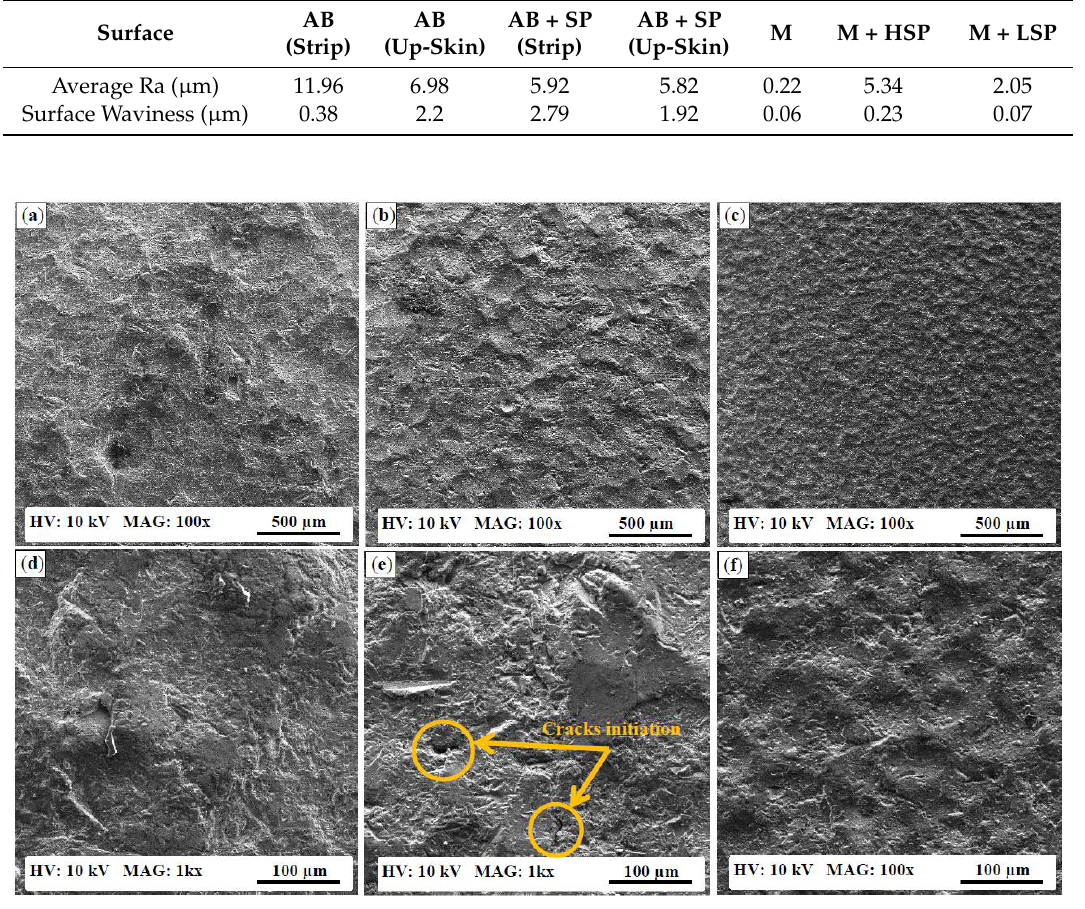
Figure 4. The impact of shot peening on the surface morphology of the AlSi10Mg sample: ( a , d ) as-built (AB) + shot-peened (SP), ( b , e ) machined (M) + high-intensity SP (HSP), ( c , f ) M + low-intensity SP (LSP).